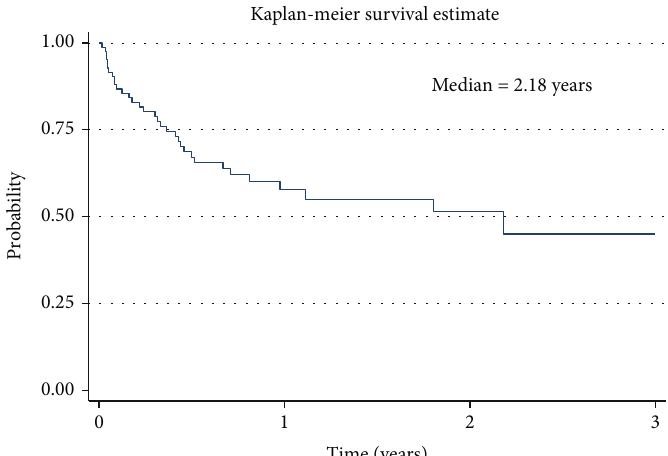
Figure 1: Graph showing the 3-year survival of children with retinoblastoma from the time of admission to the Uganda Cancer Institute.